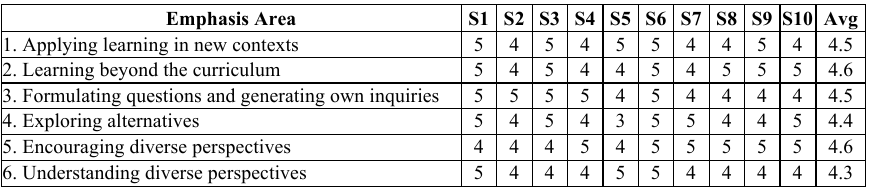
Table 4. Results [13] - Student Perceptions of Discussion